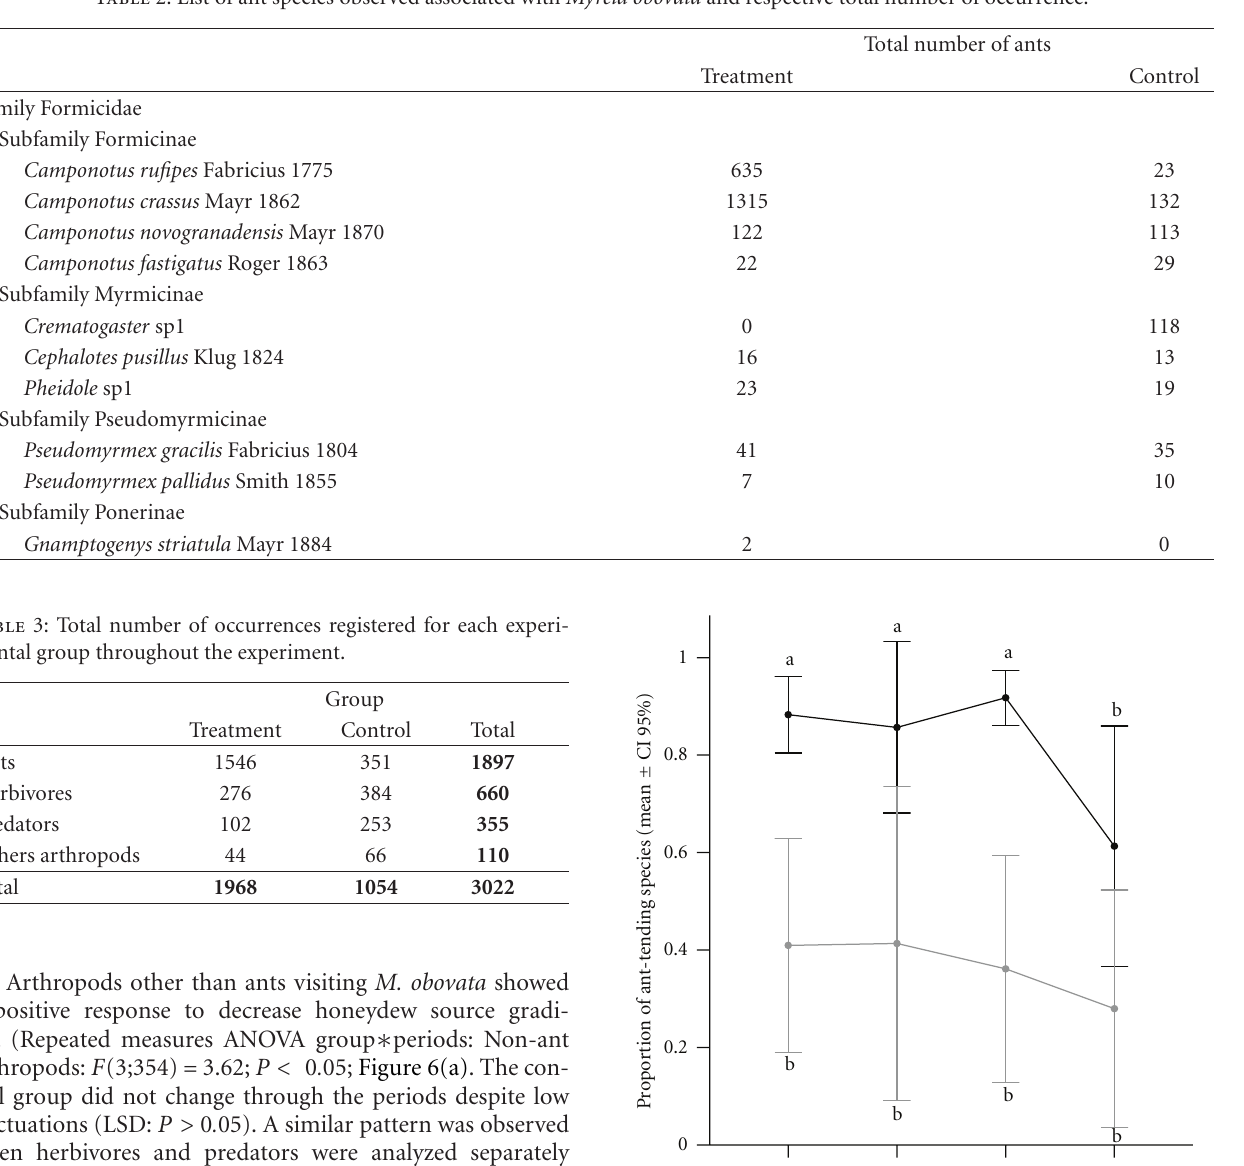
Table 2: List of ant species observed associated with Myrcia obovata and respective total number of occurrence.